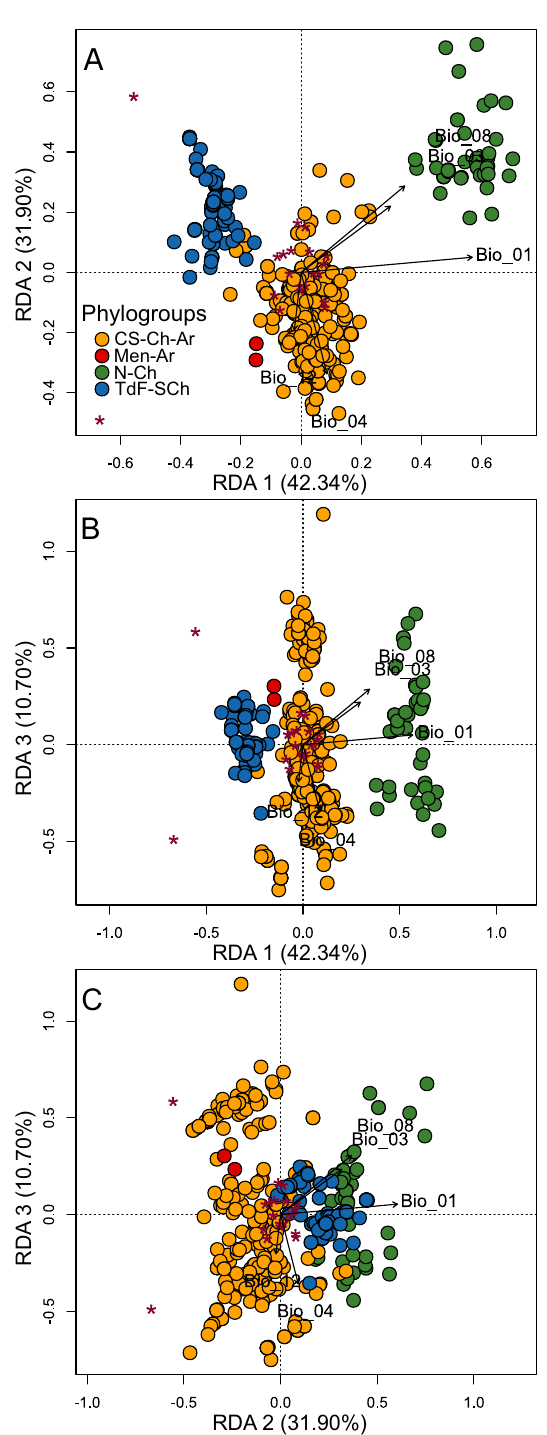
Figure 2. Triplot showing the climatic variables that best explain the pattern of mitochondrial genetic structure of Abrothrix olivacea implementing a Partial Redundancy Analysis (RDA) conditioned by geographic distance. Sampled individuals are represented by the circles, which are colored according to their correspondence to each mitochondrial phylogroup (see legend). Red asterisks represent the scores of the first 20 principal components of the gPCA that were employed as response variables. Arrows correspond to the variables that were significant ( p -value ≤ 0.05) for the analysis, according to results obtained with the ordistep function (see Table 5); their length indicates the magnitude of their explicative contribution, and the angle reflects the correlation among them. From ( A – C ), the orthogonal projections of the first three RDA axes, which cumulated 84.93% of explained variance, are shown (see Table